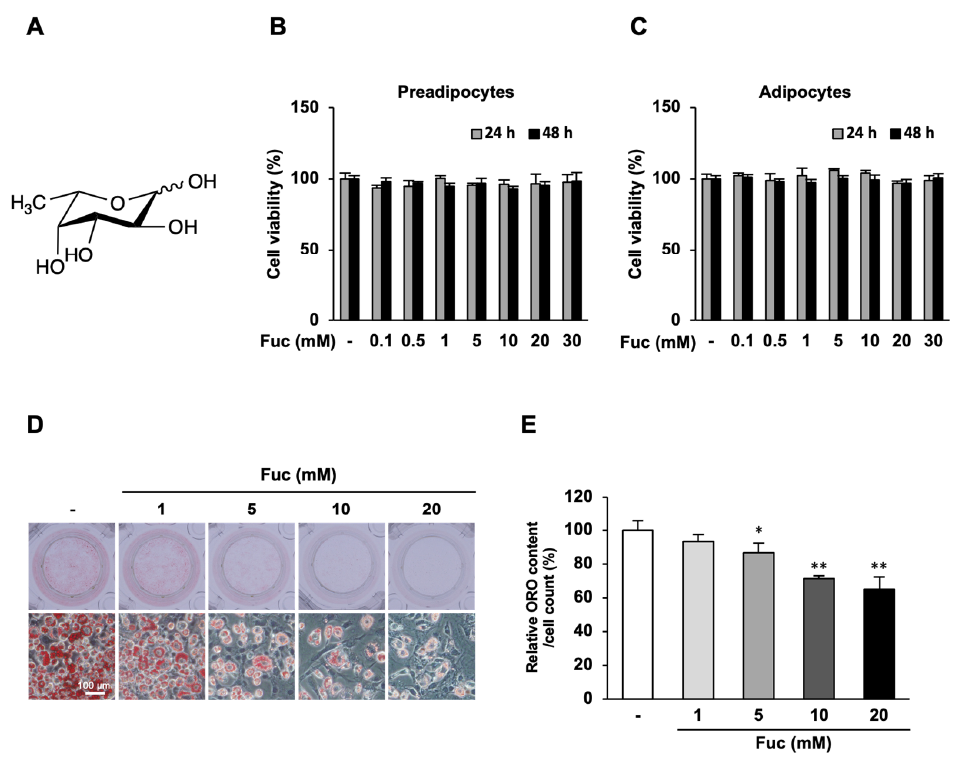
Figure 1. Effects of L-fucose (Fuc) on lipid accumulation during adipocyte differentiation. The cells were differentiated into adipocytes for eight days with or without Fuc and stained with Oil Red O.